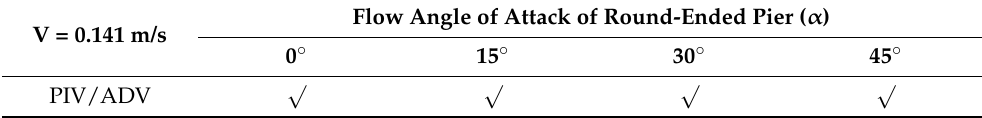
Table 1. Bridge pier flow model test